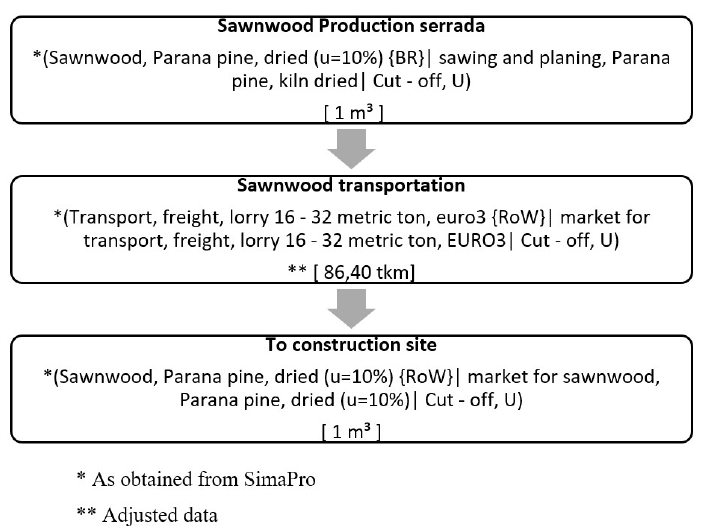
Figure 2. Flowchart with adjusted data for wooden